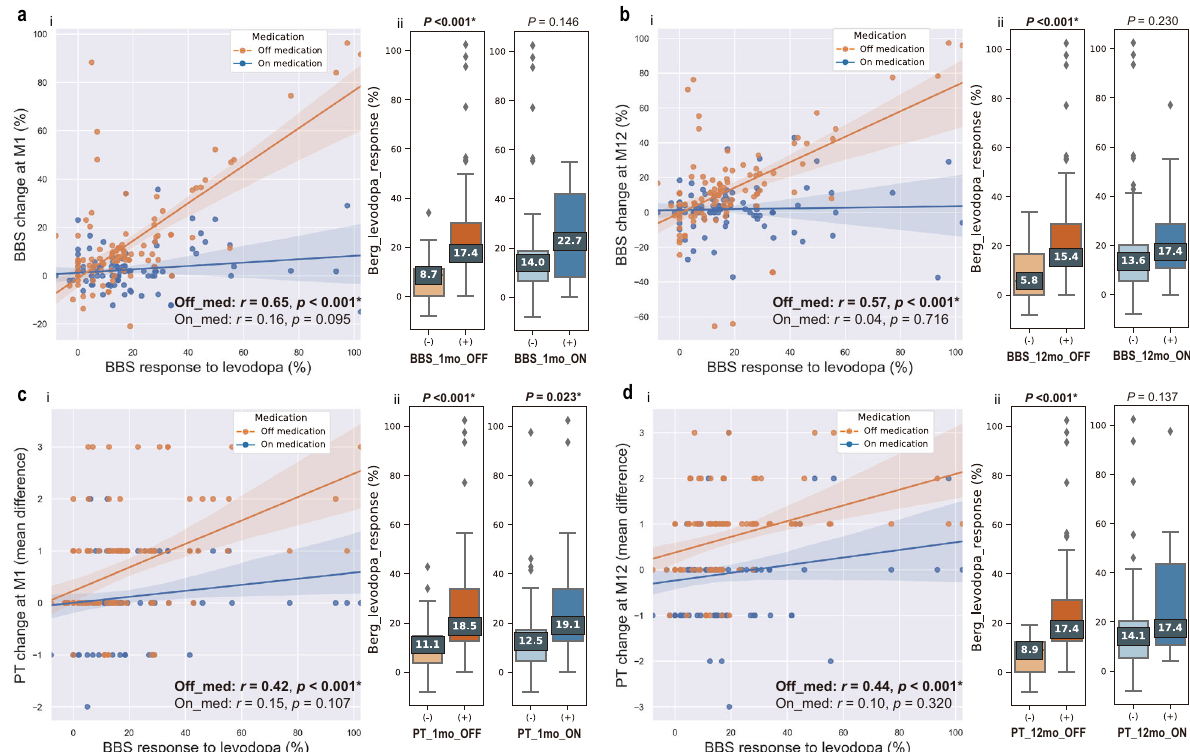
Fig. 3 Validation of BBS response to levodopa in predicting balance improvement. a -i Scatter plot and least square regression fi t curve between BBS response to levodopa and BBS change rate at M1. Orange dots indicate off-medication condition. Blue dots indicate on- medication condition. a -ii Box plots showing comparisons of BBS response to levodopa between BBS diagnosed balance-improved groups and non-improvement groups in off-medication conditions (left) and on-medication conditions (right) at M1. Dark orange/blue indicates the balance-improved group and light orange/blue indicates the non-improvement group. b -i Scatter plot and least square regression fi t curve between BBS response to levodopa and BBS change rate at M12. b -ii Box plots showing comparisons of BBS response to levodopa between BBS diagnosed balance-improved groups and non-improvement groups in off-medication conditions (left) and on-medication conditions (right) at M12. c -i Scatter plot and least square regression fi t curve between BBS response to levodopa and PT change value at M1. c -ii Box plots showing comparisons of BBS response to levodopa between PT diagnosed balance-improved groups and non-improvement groups in off-medication conditions (left) and on-medication conditions (right) at M1. d -i Scatter plot and least square regression fi t curve between BBS response to levodopa and PT change value at M12. d -ii Box plots showing comparisons of BBS response to levodopa between PT diagnosed balance-improved groups and non-improvement groups in off-medication conditions (left) and on-medication conditions (right) at M12. Signi fi cant p values are highlighted in bold. For boxplots, minimum and maximum are represented by lower and upper whiskers, respectively. The box signi fi es the fi rst and the third quartile, and the median is represented by the marked center value within the box. BBS, Berg